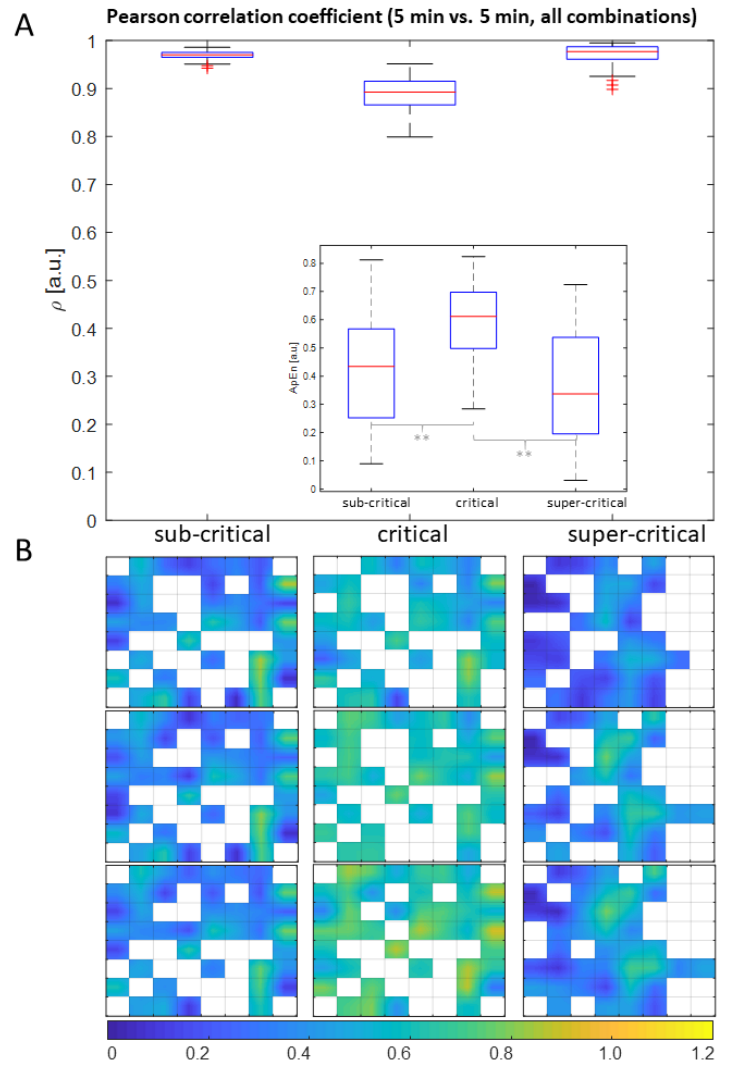
Figure 5. ( A ) Distributions of the Pearson correlation coefficients computed for all the possible combinations between the ApEn distribution of the twelve sub-recordings lasting five minutes that composed each record of one hour; in the inset, an example of the ApEn distributions for a 5 min record is depicted. The asterisks indicate the statistical difference assessed by a Mann–Whitney U-test followed by a Bonferroni correction (** means p < 0.01). ( B ) Three triplets of maps showing